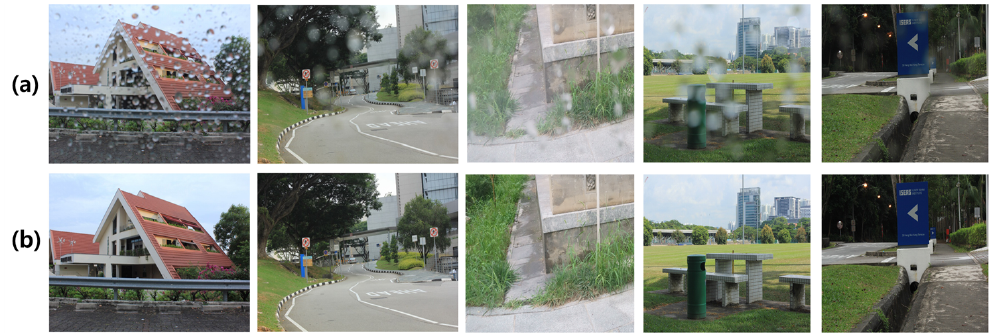
Figure 3. Samples selected from the Raindrop1119 dataset [14] ( a ) images degraded by raindrops; and ( b ) their corresponding ground-truth